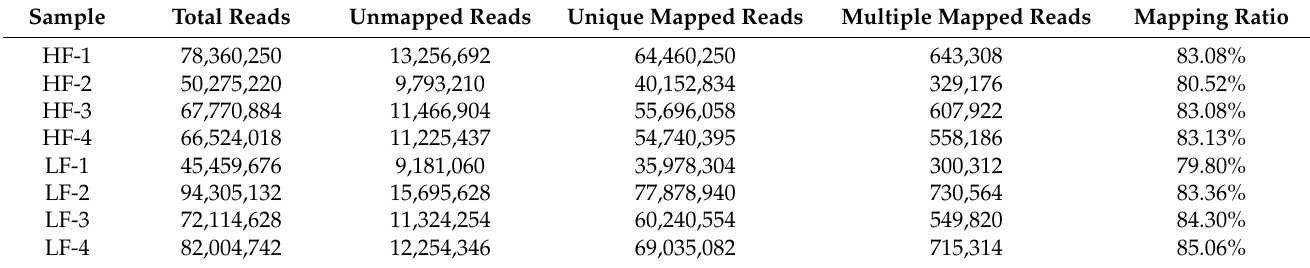
Table 4. Comparison of gene statistics.